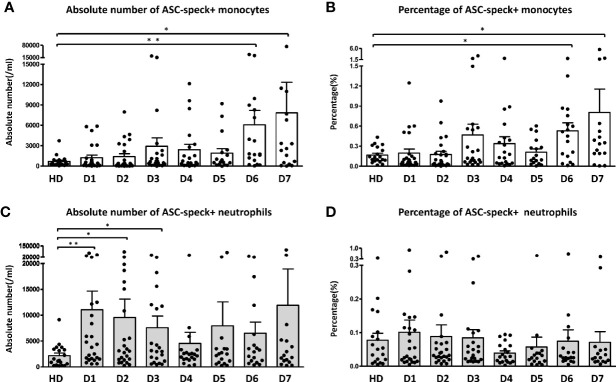
Dynamic change of ASC-speck+ cells in different leukocyte subsets. Both absolute number (A) and percentage (B) of ASC-speck+ monocytes increased significantly on day 6 and 7. The absolute number (C) of ASC-speck+ neutrophils increased during the first three days. However, no significant change of the percentage (D) of ASC-specks in neutrophils within seven days has been observed. The difference between healthy donors and patients was determined by Mann-Whitney test. *p < 0.05, **p < 0.01. Healthy donors n = 19; Sepsis patients day1 n = 24, day 2 n = 24, day 3 n = 22, day 4 n = 20, day5 n = 17, day 6 n = 18, day 7 n = 16. Dot plots and bar graph data are represented as mean ± SEM.